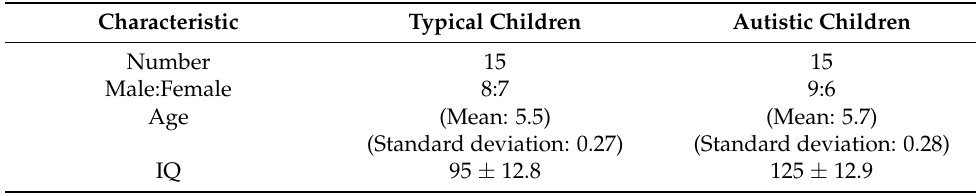
Table 1. Participant characteristics.